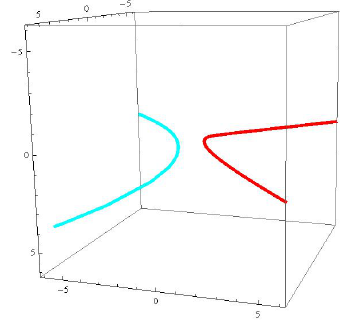
Figure 3. The red (blue) curve is the generalized T ( B ) -associate curve b 1 ( b 2 ) of r .